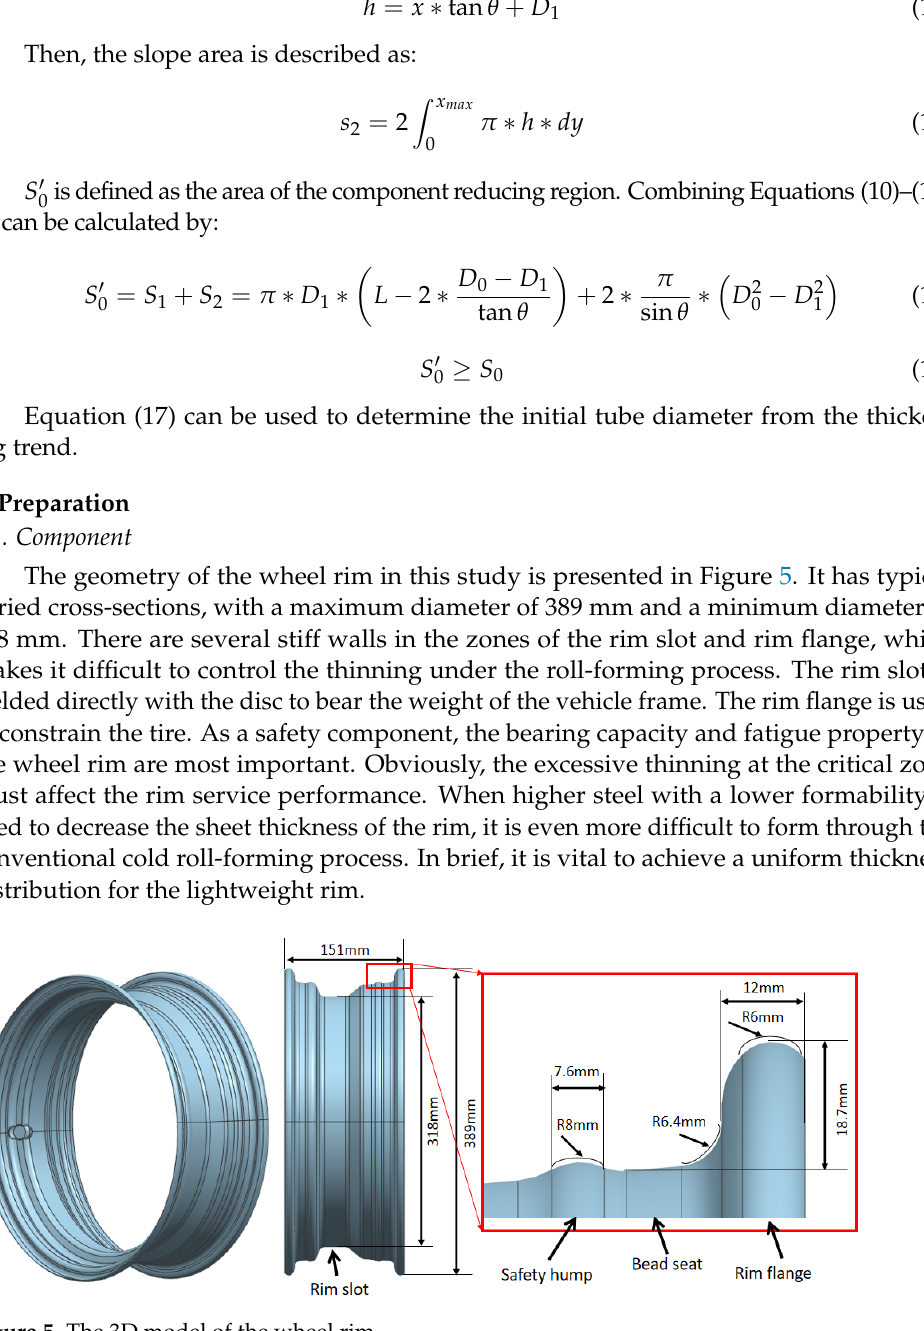
Table 1. Chemical compositions of test material w/%. Steel